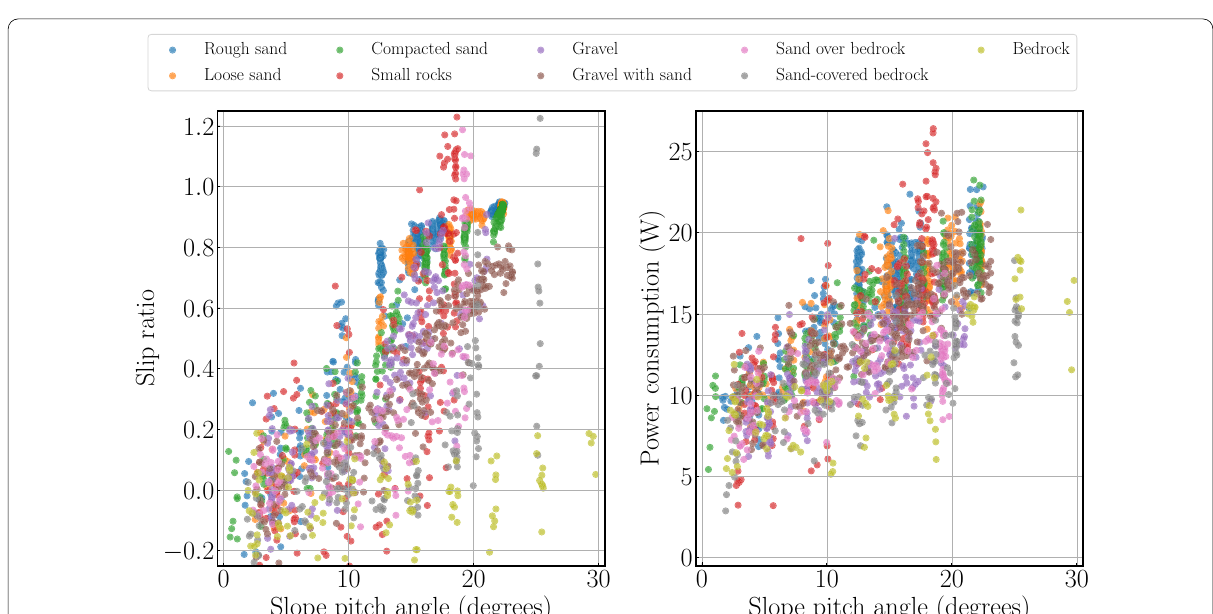
Fig. 5 Dataset of slip vs. slope and power consumption vs. slope collected on nine different surfaces. The slip values higher than 1.0 on small rocks and sand-covered bedrock were triggered by the downhill skid as the vehicle attempted to move uphill. The negative slip values mainly resulted from errors in the wheel and visual-inertial odometries, as well as the incomplete time synchronizations of these data. Individual data of each domain is plotted in Fig. 6 for slip and Fig. 7 for power